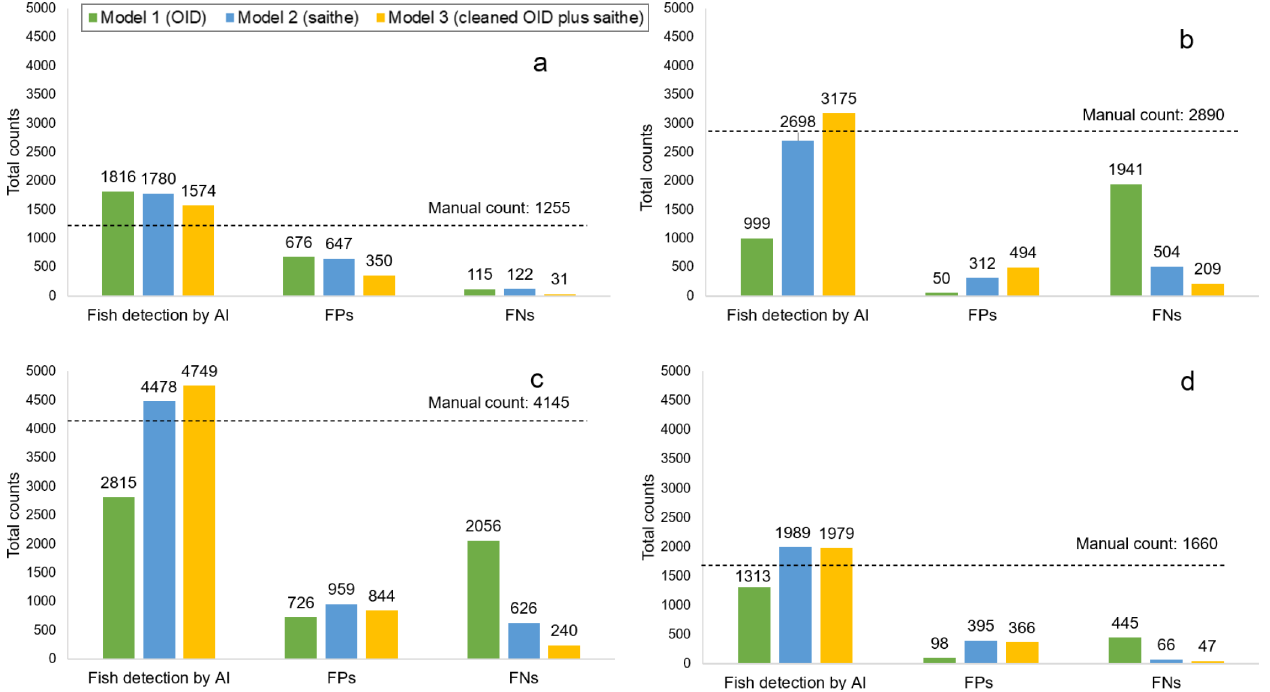
Fig. 9. Comparison of false positives (FPs) and false negatives (FNs) when different models were used in (a) the FP test set (100 images that had the highest number of FPs when Model 1 was used), (b) the FN test set (100 images that had the highest num- ber of FNs when Model 1 was used), (c) the combined test set (combination of FP and FN test sets), and (d) the 864 images taken around the test cage (Cage 1 on 8 July). Dotted line: total manual fish counts by manual work using the same